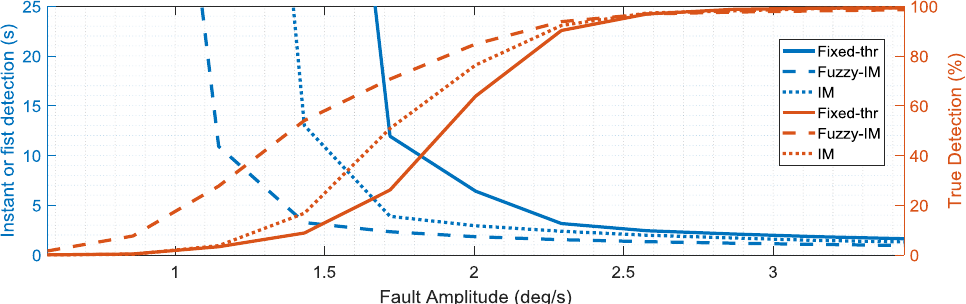
Figure 15. FD performance indexes for the r ( k ) sensor as function of the fault amplitude (mean values evaluated for the four validation flights).